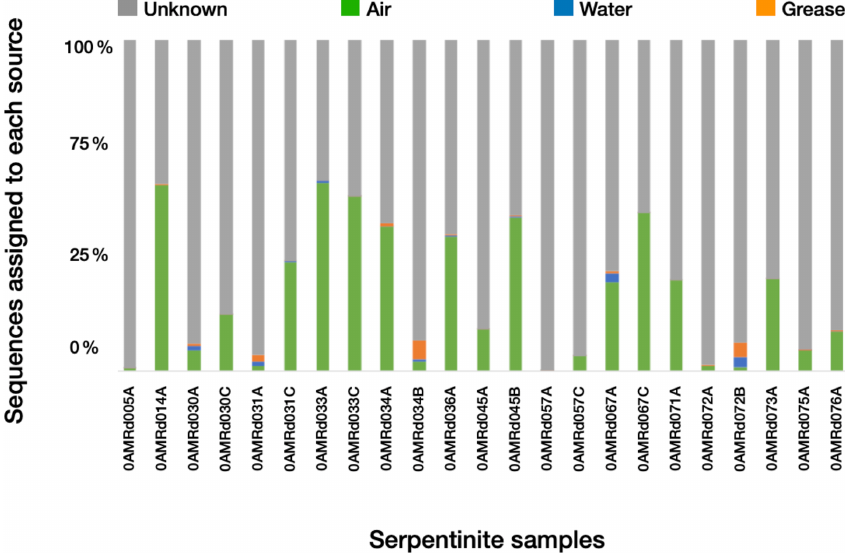
Figure 3. Estimated sources of DNA sequences into rock core samples. SourceTracker2 (Knights et al., 2011) was used to identify the most likely source of OTUs into the rock cores. Possible sources were laboratory air (green), seawater (blue), or drilling grease or oil (orange). OTUs with an “unknown” source could not be assigned to a single source and may represent rock-hosted